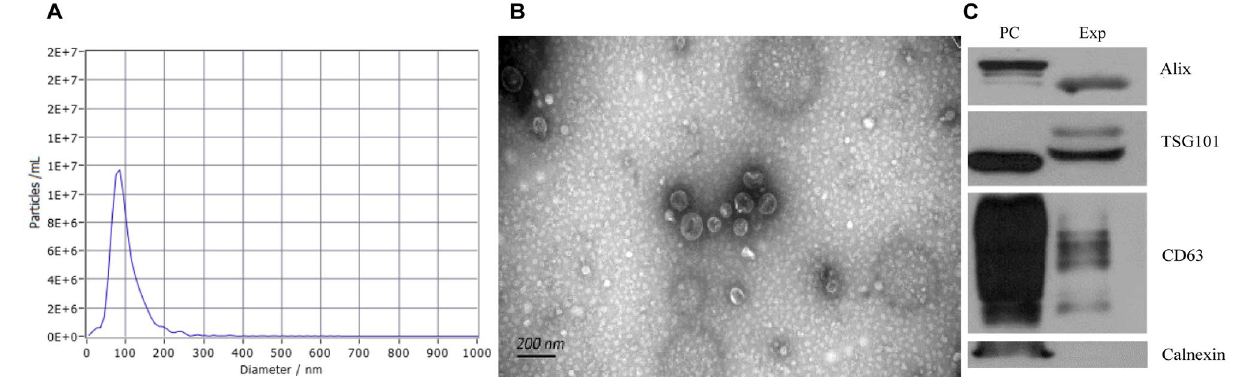
Figure 1. Characterization of exosomes derived from HCs and SUDs peripheral blood. ( A ) Representative nanoparticle tracking analysis report of exosomes from study participants. ( B ) Representative transmission electron micrograph images of exosomes derived from study participants, scale bar = 200 nm. ( C ) Western blot analysis showing the presence of three common positive exosomal markers (CD63, TSG101 and ALIX) and one negative exosomal marker (Calnexin) in exosomes isolated from study participants. PC positive control, Exp Experimental